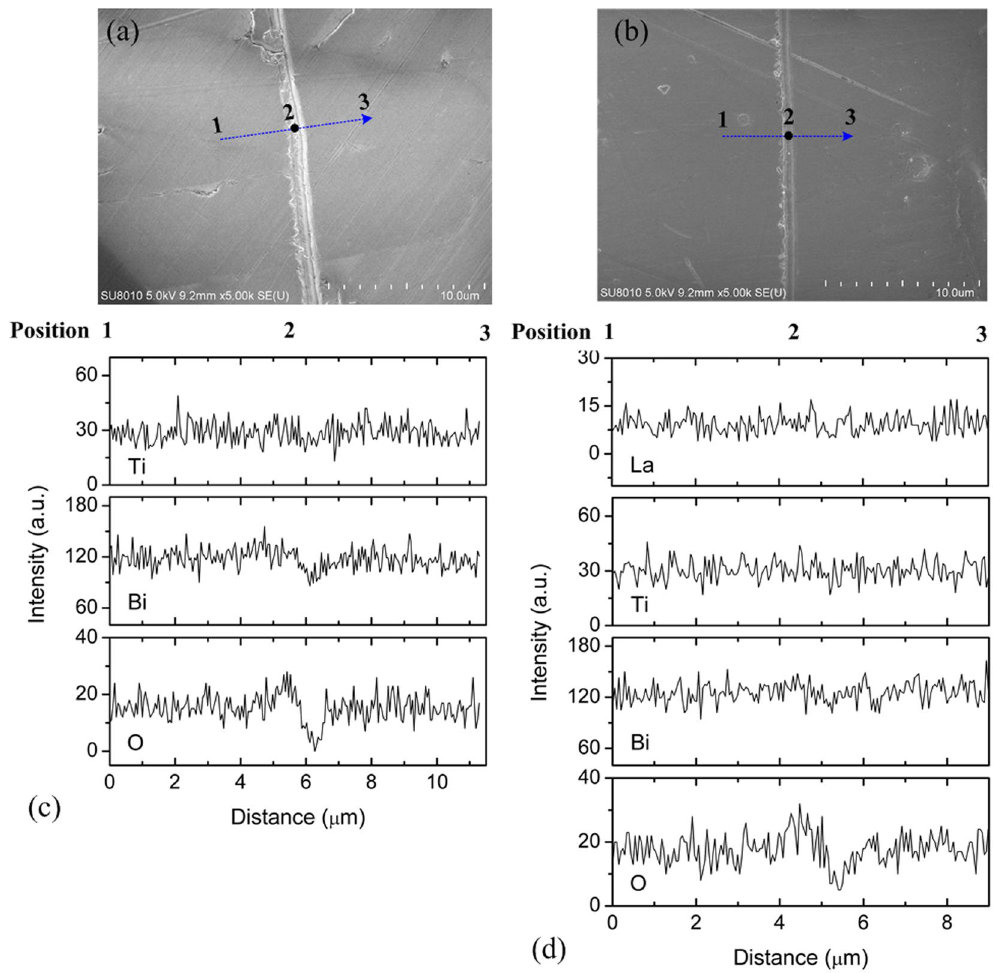
Figure 2. Microstructure of the grain-boundary region of polished (without thermal etching) ( a ) BiT-Bi and ( b ) BiT-La. EDS line scans (line 1 → 3) across the grain-boundary for ( c ) BiT-Bi and ( d )